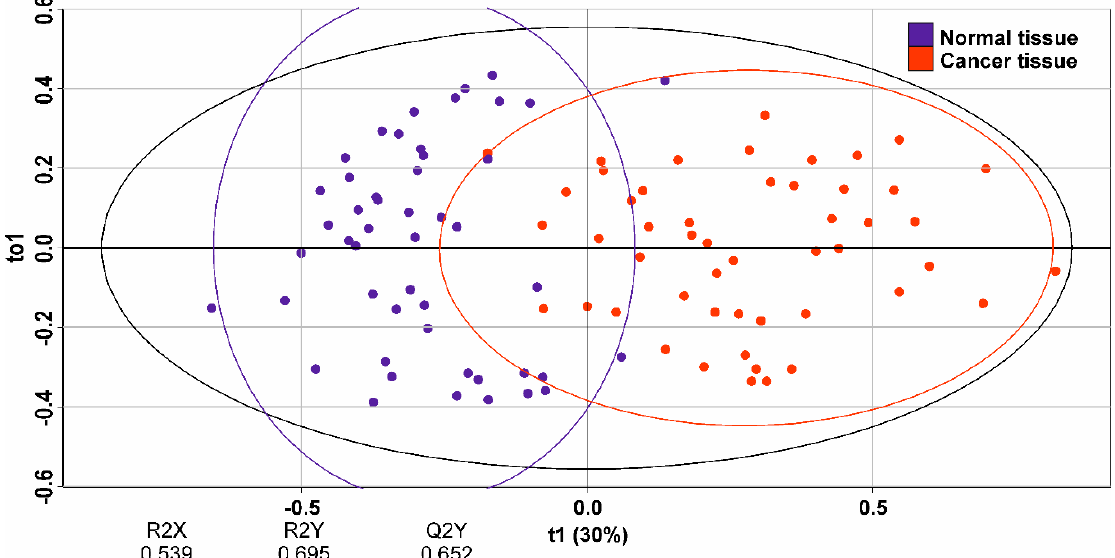
Figure 5. Scores plot of the orthogonal projections to latent structures discriminant analysis (OPLS-DA) model for separation of pathological (red dots) and normal (blue dots) tissues.